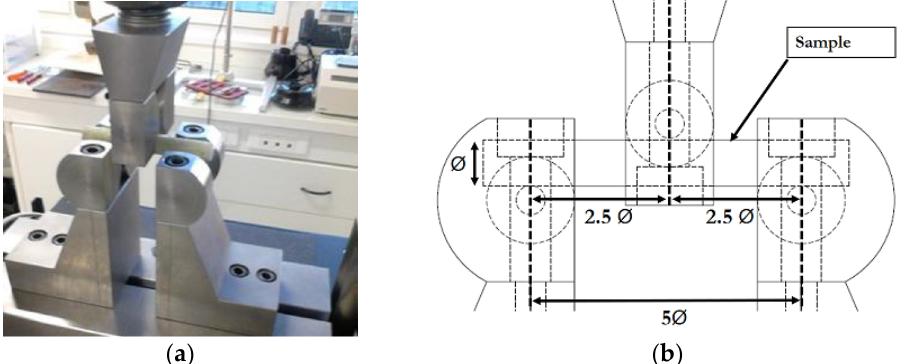
Figure 6. Short-beam test: ( a ) picture and ( b ) detailed scheme of the test configuration (dimensions are in mm).